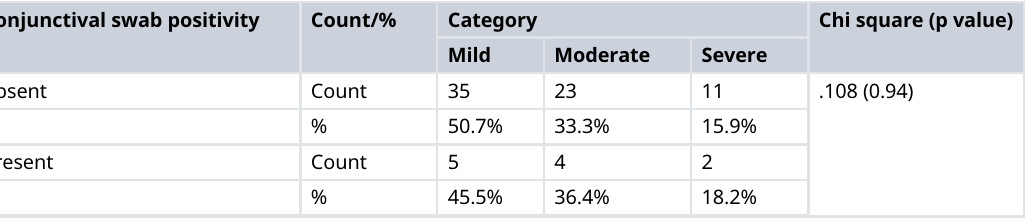
Table 3. Conjunctival swab positivity *